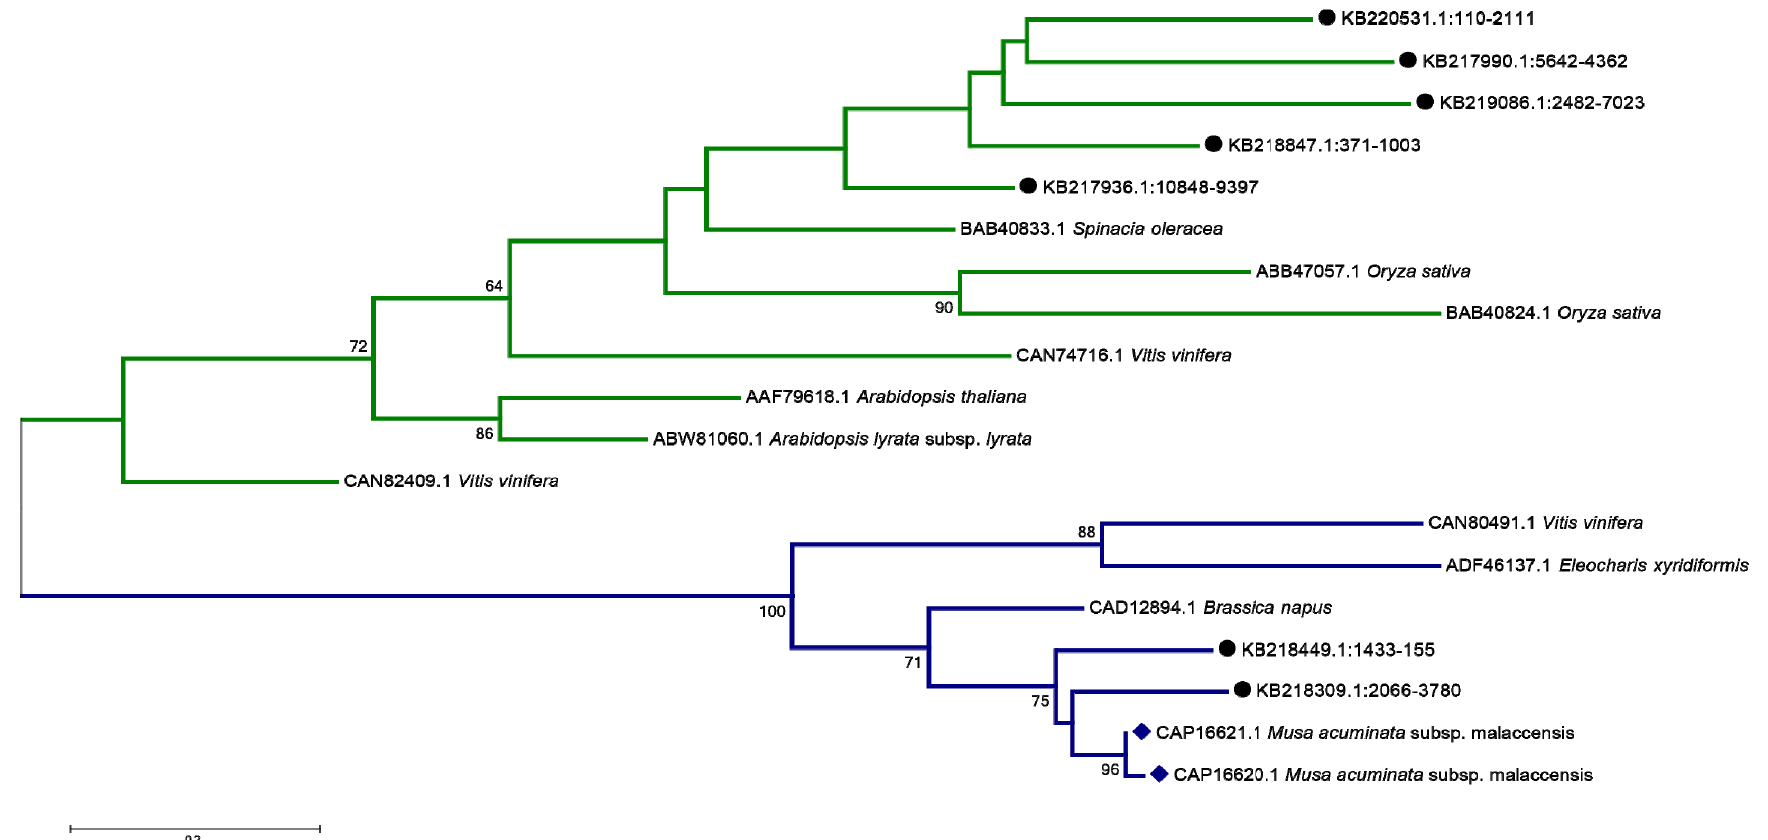
Figure 5. Maximum-Likelihood phylogenetic tree for enset reverse transcriptase-domain proteins. Protein sequences from E. ventricosum are indicated by circles. The sequences from M. acuminata are indicated by diamonds. Bootstrap values of greater than 50% are indicated as numbers on the